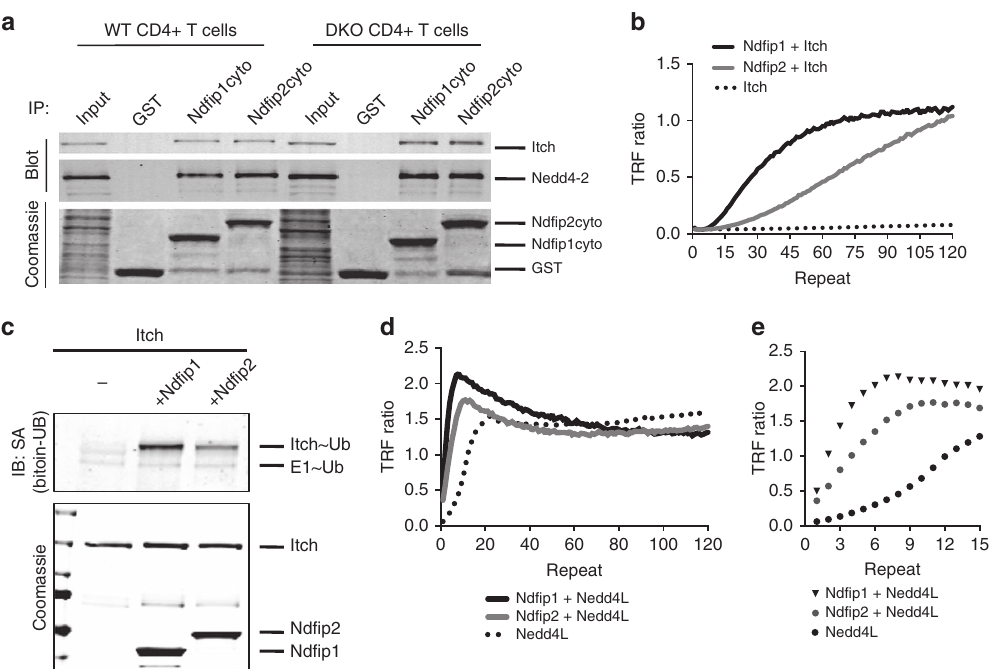
Figure 6 | Ndfip1 and Ndfip2 promote Itch and Nedd4-2 activity. ( a ) Immunoblot of Itch and Nedd4-2 isolated from activated WTor Ndfip1/Ndfip2 DKO CD4 þ T-cell lysates by GSTpulldown of Ndfip1 and Ndfip2 cytosolic domain GST fusion proteins. Coomassie stain for the GST fusion proteins revealed full-length products for each construct as well as a GSTcleavage product. ( b ) Itch activity, in the absence or presence of Ndfip1 or Ndfip2, was analysed via TR-FRET polyubiquitylation assay. ( c ) E2/E3 transthiolation assay was used to test whether Ndfip2 promotes ubiquitin ‘charging’ of Itch. Biotinylated ubiquitin non-covalently bound to Itch was analysed by western blot using fluorescent streptavidin (top); total protein was visualized by Coomassie stain (bottom). ( d , e ) As in b , human Nedd4L activity was assessed alone or in the presence of Ndfip1 or Ndfip2 by TR-FRET. Data for each panel is representative of a minimum of three independent